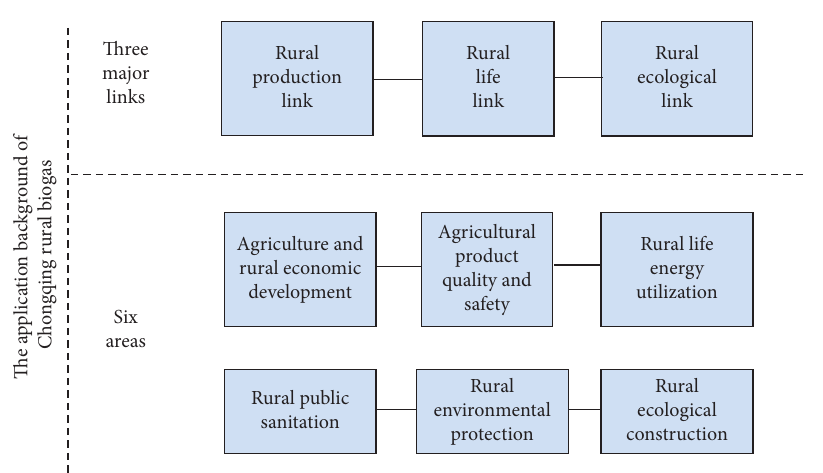
Figure 3: Schematic diagram of the application background of Chongqing rural biogas energy. Chart source: the authors.